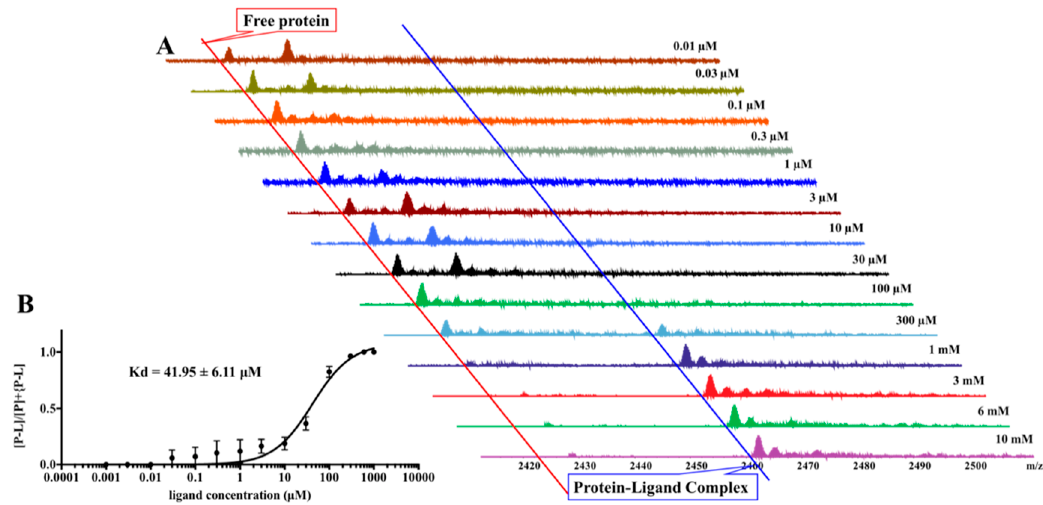
Figure 4. Determination of the pseudo- K d between altholactone and Rv1466. ( A ) Overlay of the 14 mass spectra of Rv1466 at a concentration of 4.5 µ M mixed with increasing concentration of pure altholactone (0.001–1000 µ M). ( B ) Plot of [P-L] / [P] + [P-L] versus ligand concentrations for the titration of Rv1466 with altholactone. The pseudo- K d was calculated as 42.0 ± 6.1 µ M.